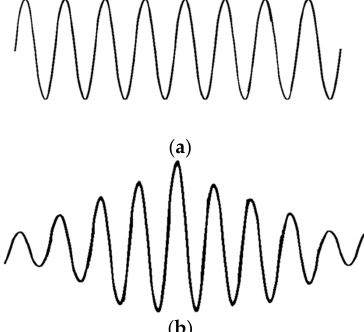
Figure 2. ( a ) Current in the resonant network of a resonant converter with a V DC source at the input, ( b ) Current in the resonant network of a resonant converter with power factor correction, as shown in Figure 1.